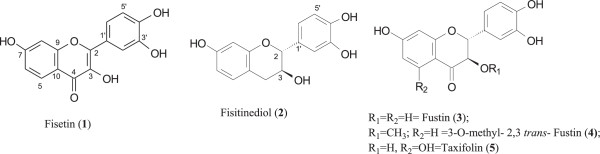
Chemical structures of the compounds 1-5.